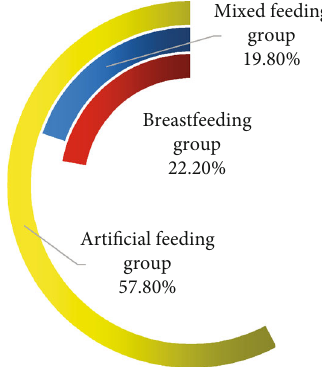
Figure 5: Comparison of infant diseases.